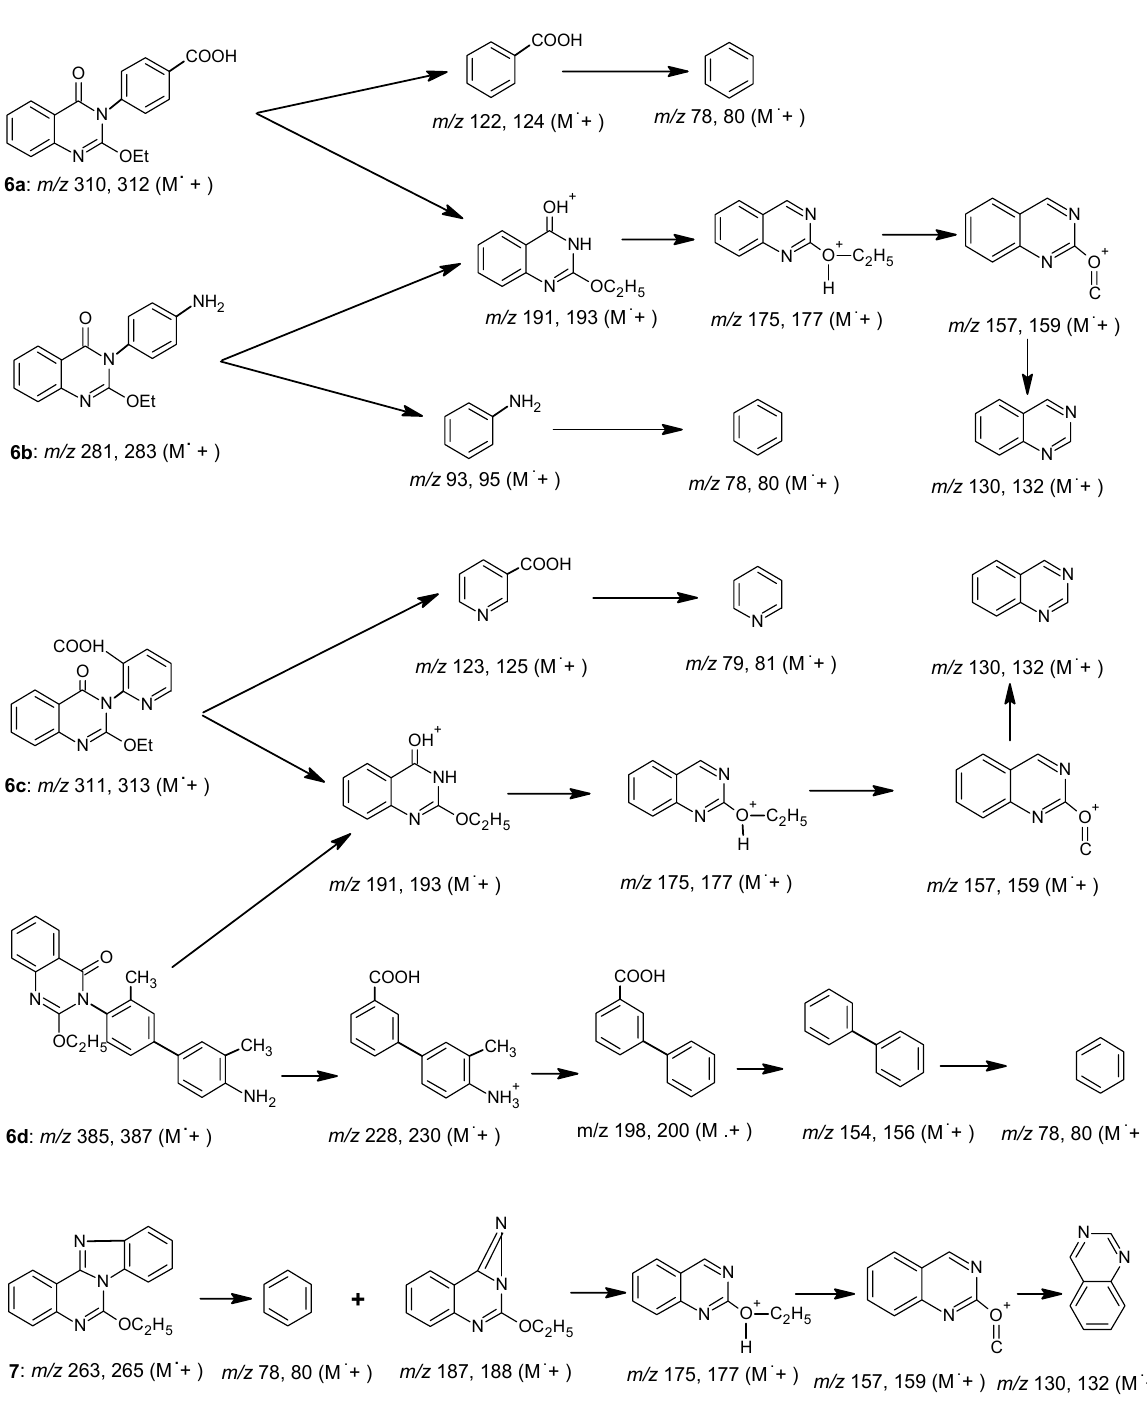
Scheme 6. Mass spectra interpretation for compounds 6a-d and 7